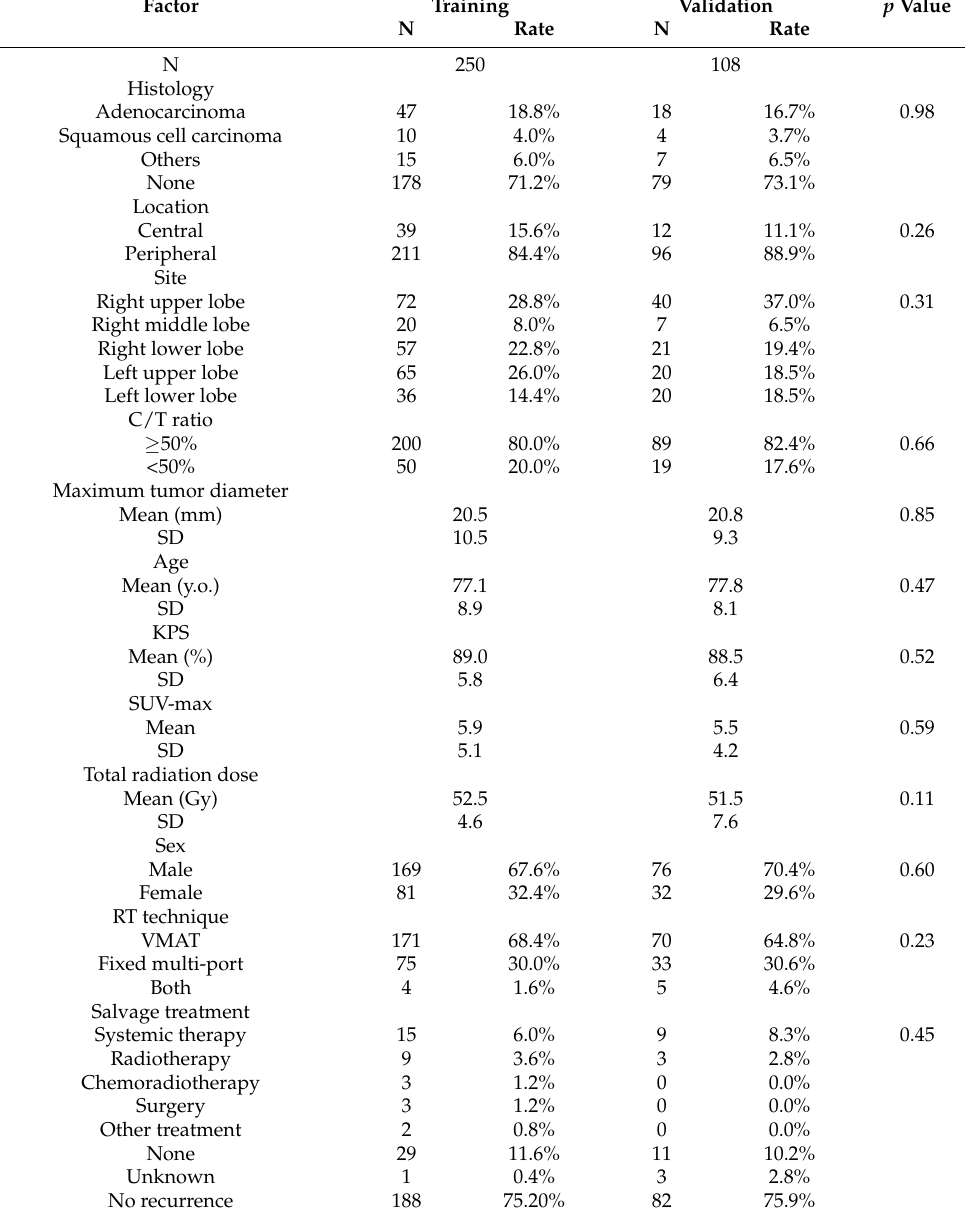
Table 1. Patient characteristics of the training and the validation